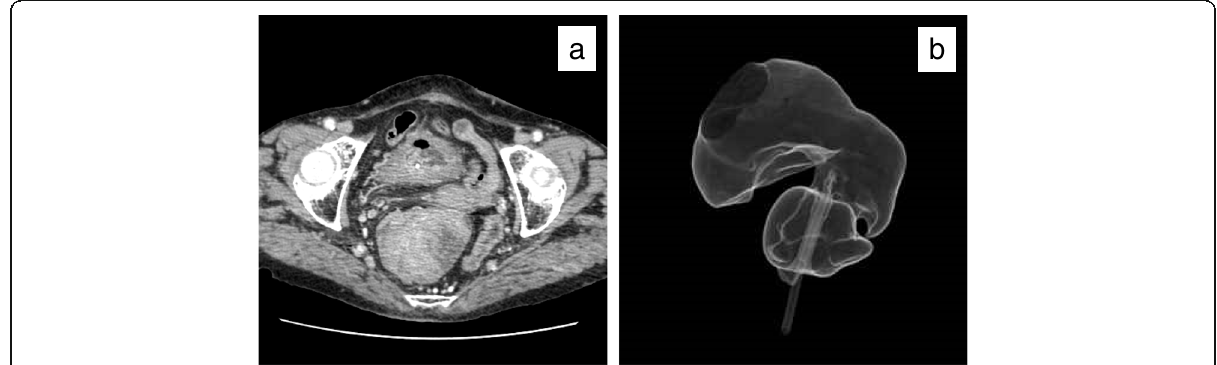
Fig. 2 Computed tomography findings. a Enhanced tumor was found in the lower rectum without lymph node metastasis. b The computed tomography colonography showed that the tumor extended into anal